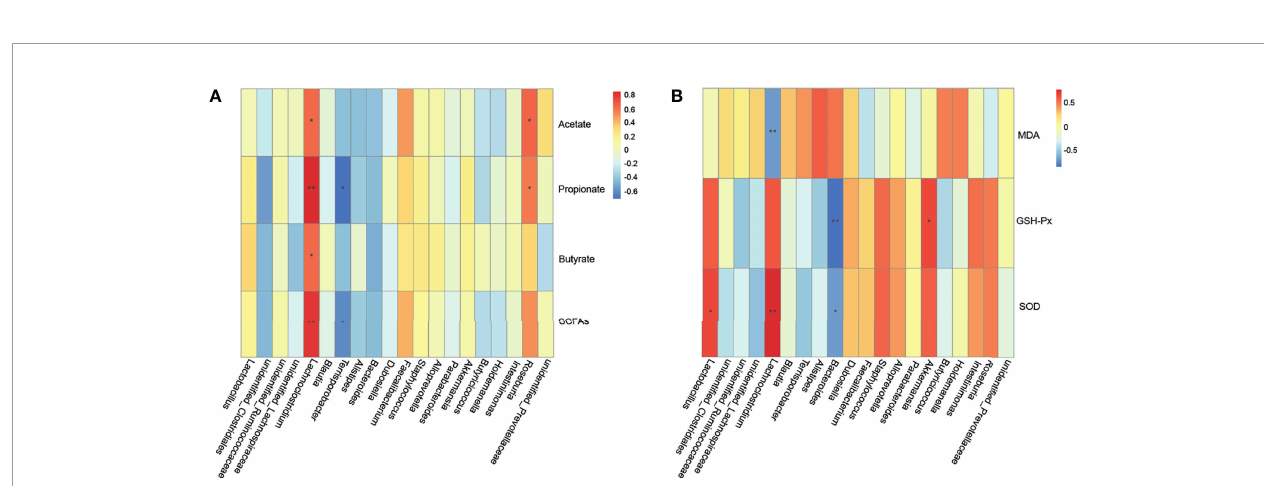
FIGURE 9 | Correlation among cecal microbiota, cecal SCFAs and oxidative stress indexes. (A) Spearman ’ s correlation analyses between the cecal SCFAs and microbiota at the genus level (n = 3 mice per group). (B) Spearman ’ s correlation analyses between the cecal microbiota and oxidative stress indexes at the genus level (n = 3 mice per group). * represents the speci fi c genus whose abundance were signi fi cantly correlated with cecal SCFAs or oxidative stress indexes. * 0.01 < p ≤ 0.05, ** 0.001 < p ≤ 0.01.